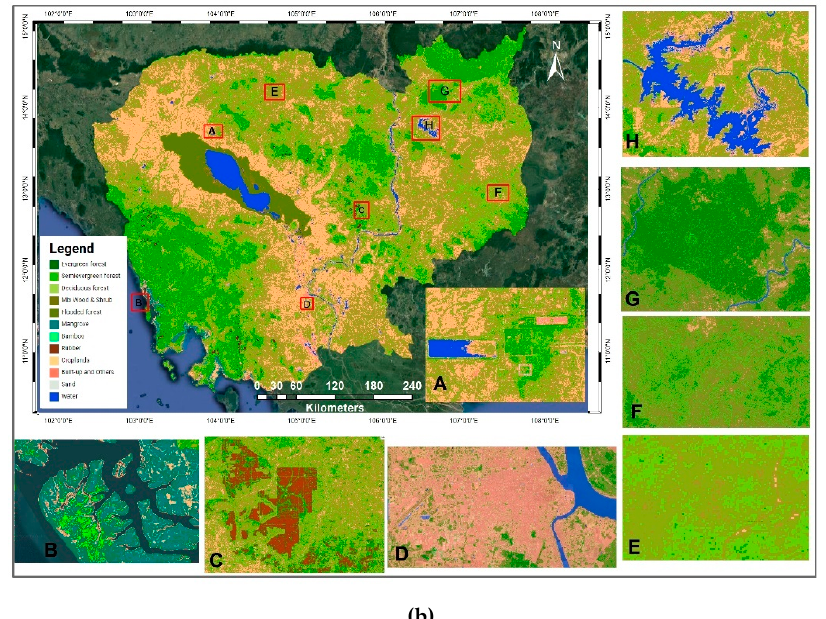
Figure 11. First resulted in the first results of the pixel-based classified land cover map of Cambodia. ( a ) OLI 2018 and ( b ) TM 2000 threshold maps of the mid-LSP season (December–February) The map legend represents the color codes and labels of land cover categories. (a): (A) represents Angkor Wat covered by EG and SEG forests, (B) mangrove forest cover, (C) rubber plantation, (D) Phnom Penh city and surroundings, (E) abundant deciduous forest and mixed wood and shrub cover, with some patches showing the croplands and bamboo, (F) the majority of semievergreen cover and dark green color shows evergreen forests, (G) dense evergreen forests, (H) predominantly bamboo cover. (b): (A) represents Angkor Wat and its surrounding evergreen and semievergreen forests, (B) mangrove forest cover, (C) rubber plantation, (D) Phnom Penh city and surroundings, (E) abundant deciduous forest and some patches of mixed wood and shrublands, (F) predominantly semievergreen cover and dark green color shows the evergreen forest, (G) Dense evergreen forest, (H) Hydropower dam.